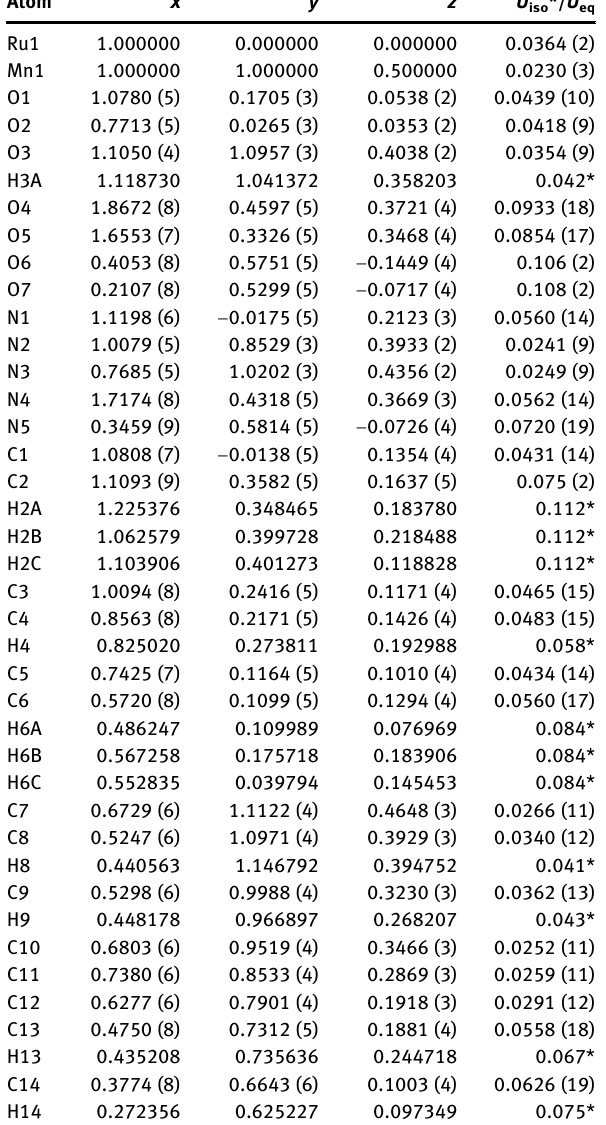
Table  : Fractional atomic coordinates and isotropic or equivalent isotropic displacement parameters (Å  ).